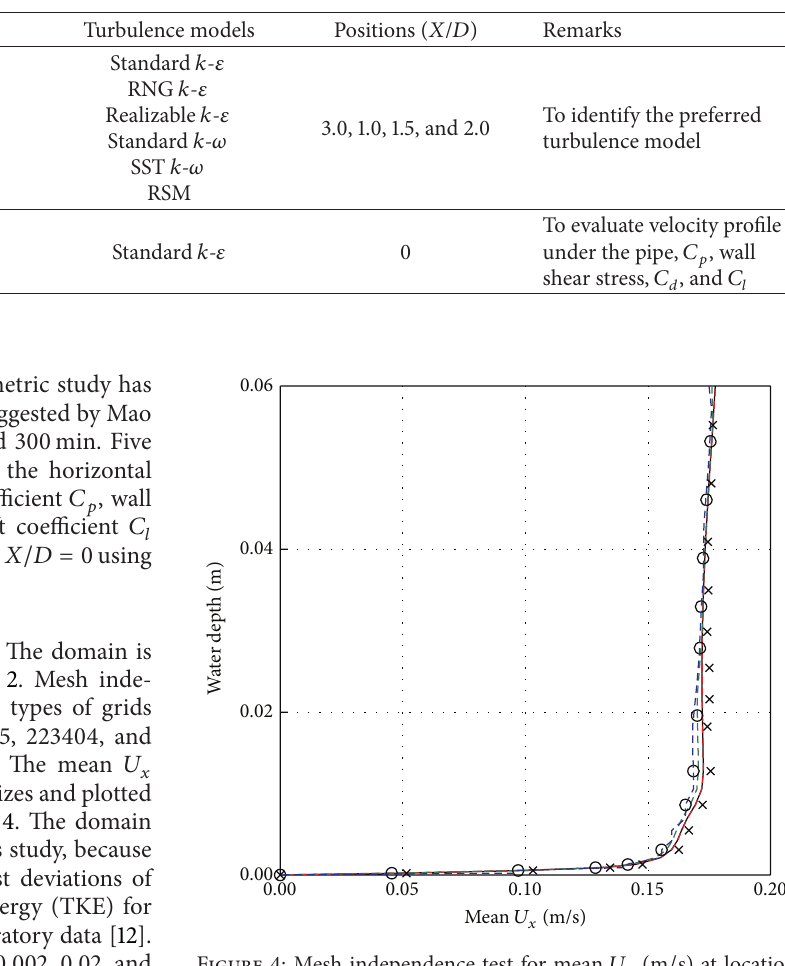
Figure 4: Mesh independence test for mean 𝑈 𝑥 ( m / s ) at location 𝑋/𝐷 = −3.0 for different types of grid cell numbers, Red